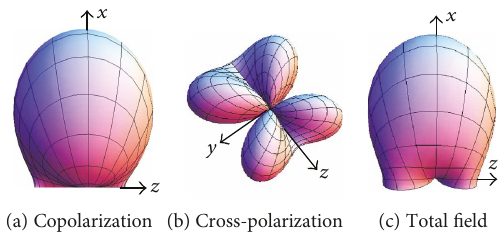
Figure 12: 3D pattern for the HB